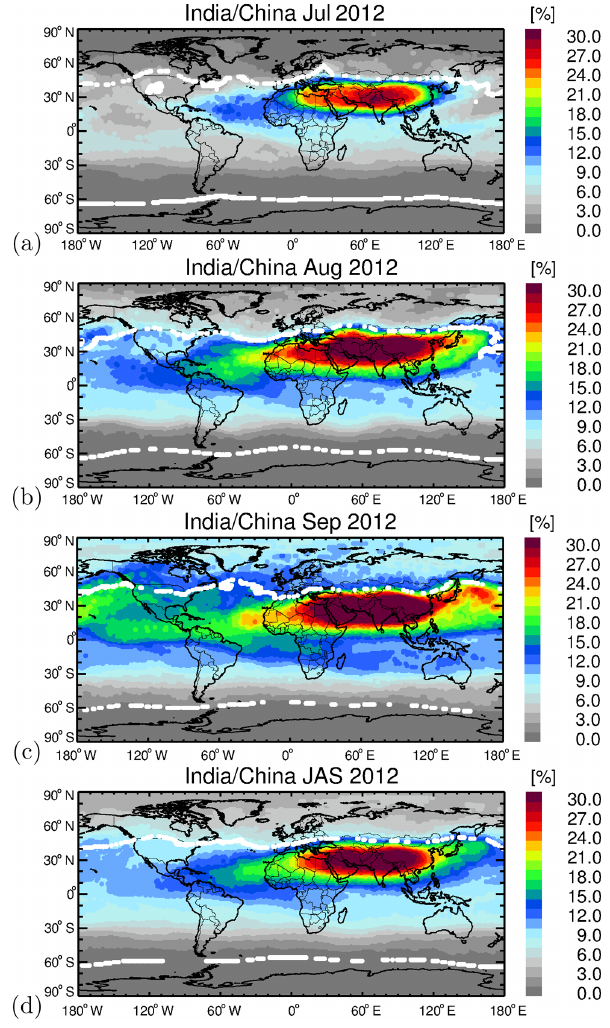
Figure 12. Mean values of the contribution of the emission tracer for India/China at 380K in July (a) , August (b) , and September (c) 2012. Panel (d) shows mean values for India/China for July, August, and September 2012. The climatological isentropic transport barri- ers of 7.2PVU (Northern Hemisphere) and − 11.5PVU (Southern Hemisphere) at 380K are shown as thick white